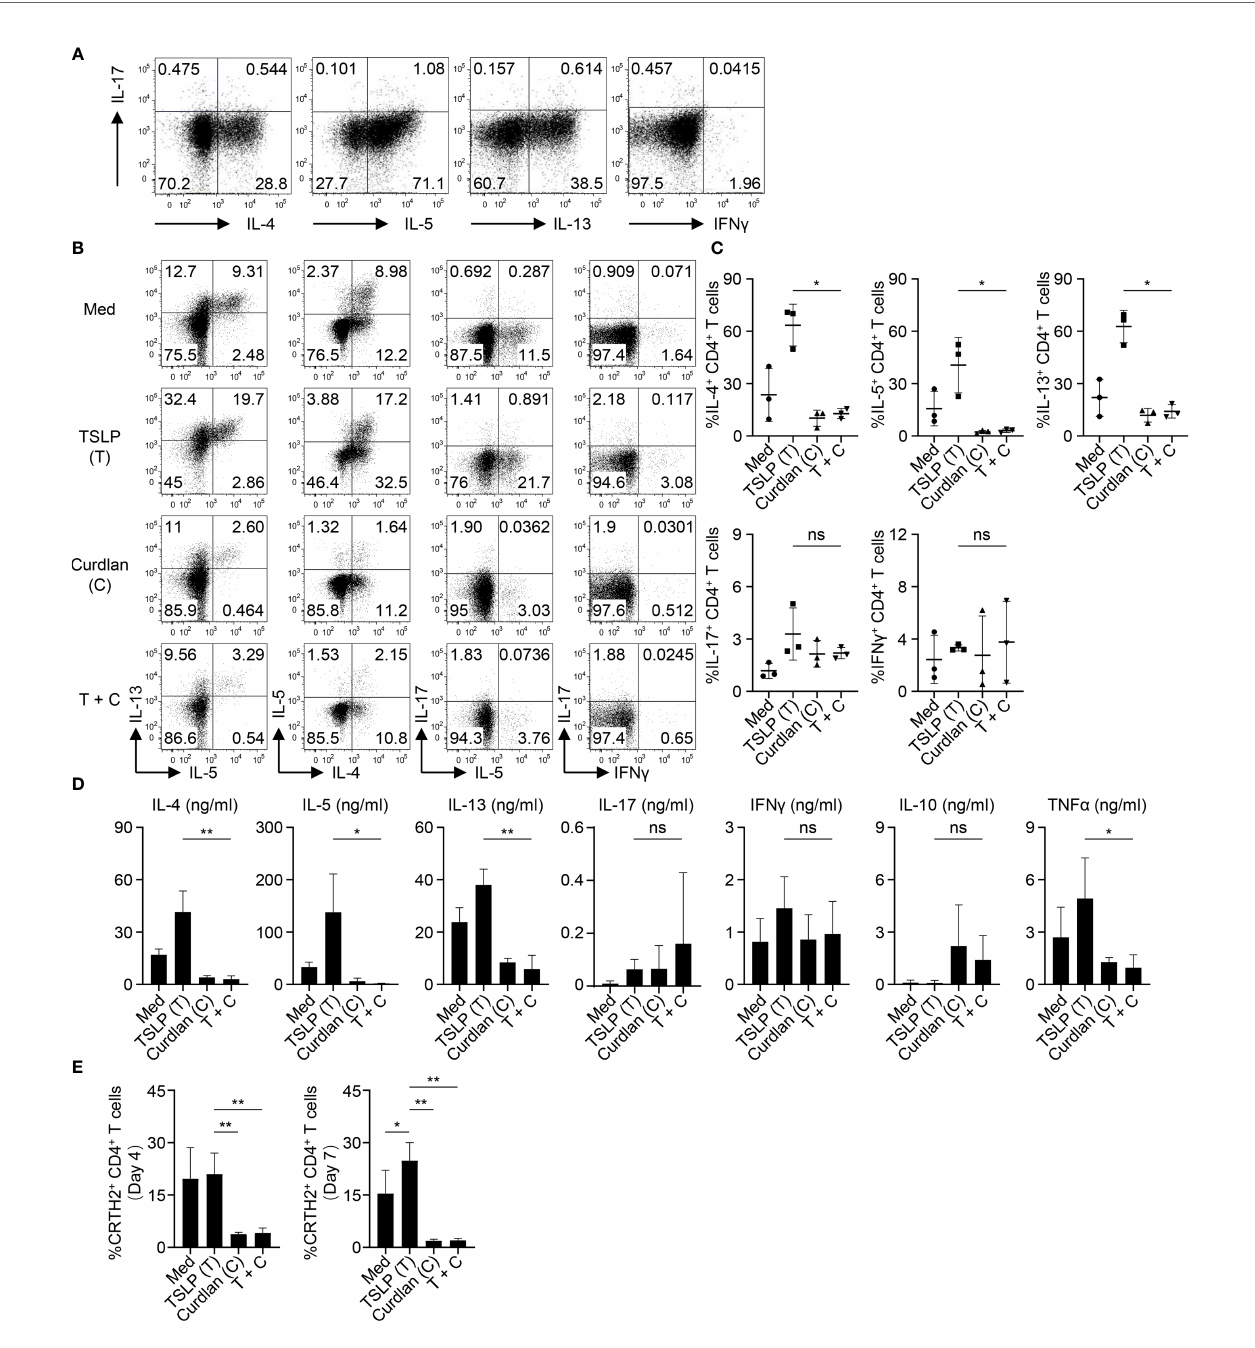
FIGURE 2 | Activation of mDCs via Dectin-1 Inhibits TSLP-Induced In fl ammatory Th2 Response of CRTH2 + Memory CD4 + T Cells. (A) Intracellular staining of cytokines expressed by sorted CRTH2 + memory CD4 + T cells upon ex vivo stimulation with PMA/ionomycin. The FACS data shown is representative of three independent experiments. (B, C) Sorted mDCs were treated with indicated reagents for 24h before coculture with autologous CRTH2 + memory CD4 + T cells for 7d followed by intracellular staining of cytokines expressed by T cells. Live singlets were gated for analysis. Representative FACS data (B) and summarized data (C) from different donors (n = 3) are shown. (D) After 5d coculture of mDCs and autologous CRTH2 + memory CD4 + T cells as in (B) , T cells were stimulated by anti- CD3/28 beads for 48h before measuring cytokine production in culture supernatants by multiplex assay. Summarized data from different donors (n = 3) are shown. (E) After 4d or 7d of coculture of mDCs and autologous CRTH2 + memory CD4 + T cells as in (B) , surface CRTH2 expression on CD4 + T cells was measured by FACS staining. Summarized data from different donors (n = 3) are shown. Data in (C – E) are represented as mean ± SD. Signi fi cance was determined using one-way ANOVA with Tukey multiple comparisons test for (C – E) . * p < 0.05, ** p < 0.01 for the comparison between groups. ns, not signi fi